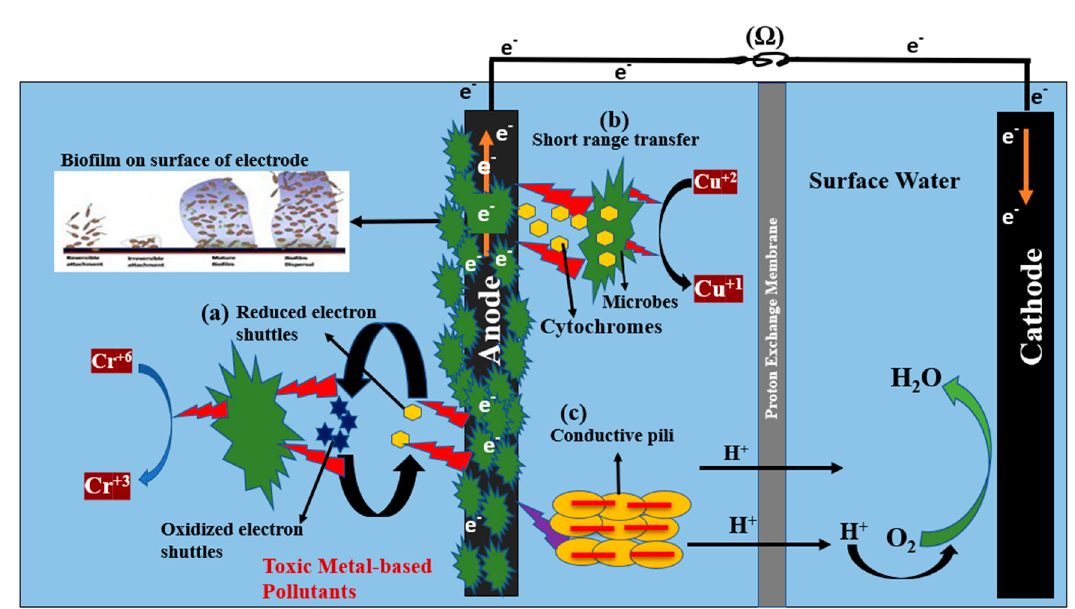
Figure 2. Reduction mechanisms of toxic metals through MFCs ( a – c ). Different mechanisms of electron transfer from microbes to electrodes. Catalysts 2020 , 10 , x FOR PEER REVIEW